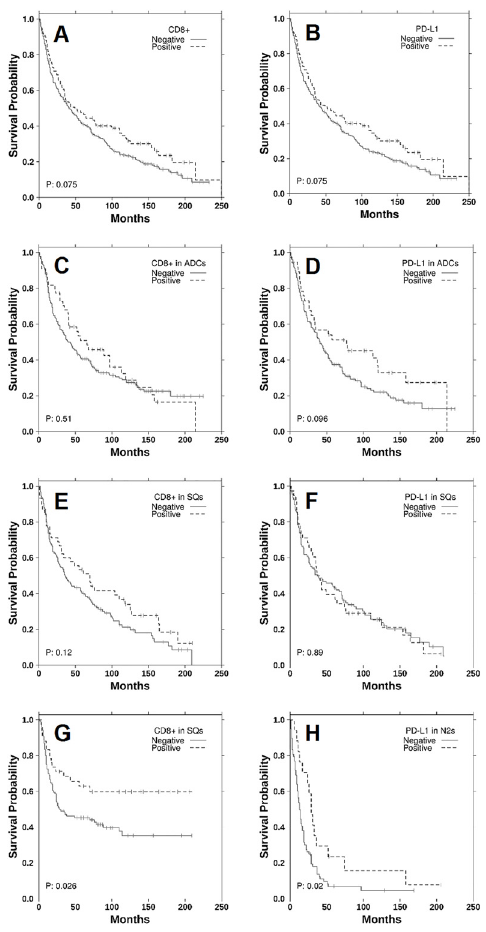
Fig 2. Kaplan-Meier curves of OS for CD8, PD-L1 status. (A) OS CD8+ TILs. (B) OS PD-L1. (C) OS CD8 + TILs in adenocarcinoma. (D) OS PD-L1 in adenocarcinoma. (E) OS CD8+ TILs in squamous cell cancer. (F) OS PD-L1 in squamous cell cancer. (G) DFS CD8+ TILs in squamous cell cancer. (H) OS PD-L1 in N2